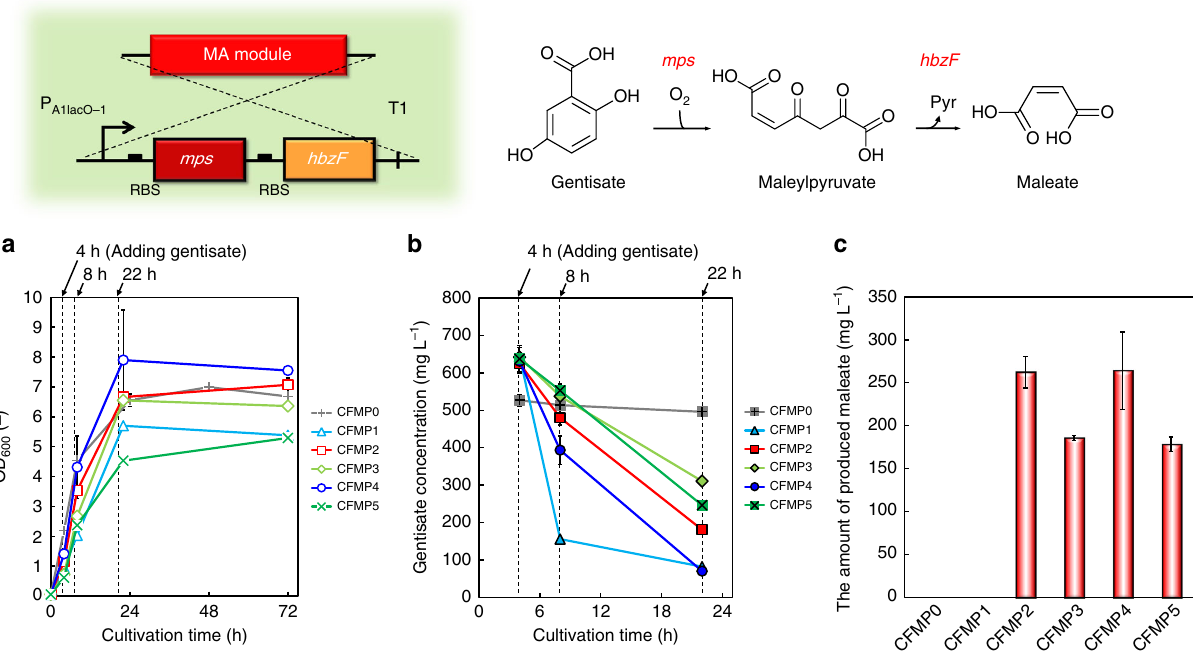
Fig. 3 Culture pro fi les of CFMP0 – 5 in M9Y medium supplemented with 500 – 600mg L − 1 gentisate. Time courses of a bacterial cell growth and b gentisate consumption. c The amount of produced maleate after 22 h of cultivation. Data are presented as the mean ± standard deviation of three independent experiments ( n = after 72 h of cultivation. The amount of gentisate produced by − 1 , which was the highest CFG1, carrying cgl3026 , was 1050 mg L level of gentisate production among the three transformants.